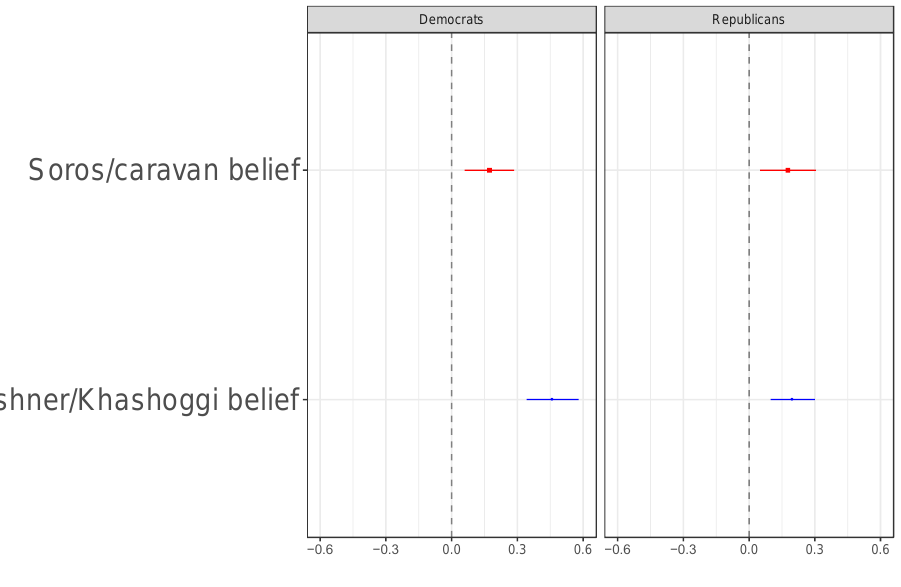
Figure 3. Effect of false article exposure on claim belief. Effect of exposure to a false article from an untrustworthy website on belief in the claim expressed in the article (fall 2018). Point estimates (with 95% confidence intervals) from separate OLS regressions. Outcome measure is a four- point accuracy scale ranging from “Not at all accurate” (1) to “Very accurate” (4). Control variables include partisanship, ideology, political knowledge, feelings toward President Trump, age, race, and college education. See Table B5 for full